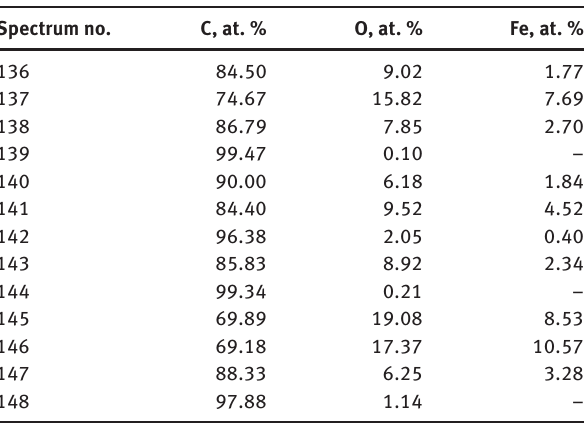
Table 4: Content of the elements carbon, oxygen and iron in the areas where spectra nos. 136–148 were scanned.